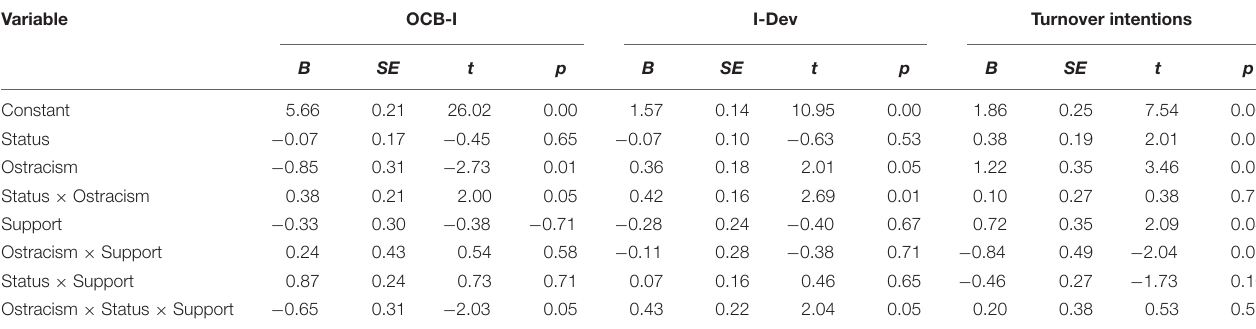
TABLE 3 | Study 1: Regression results for three-way interaction